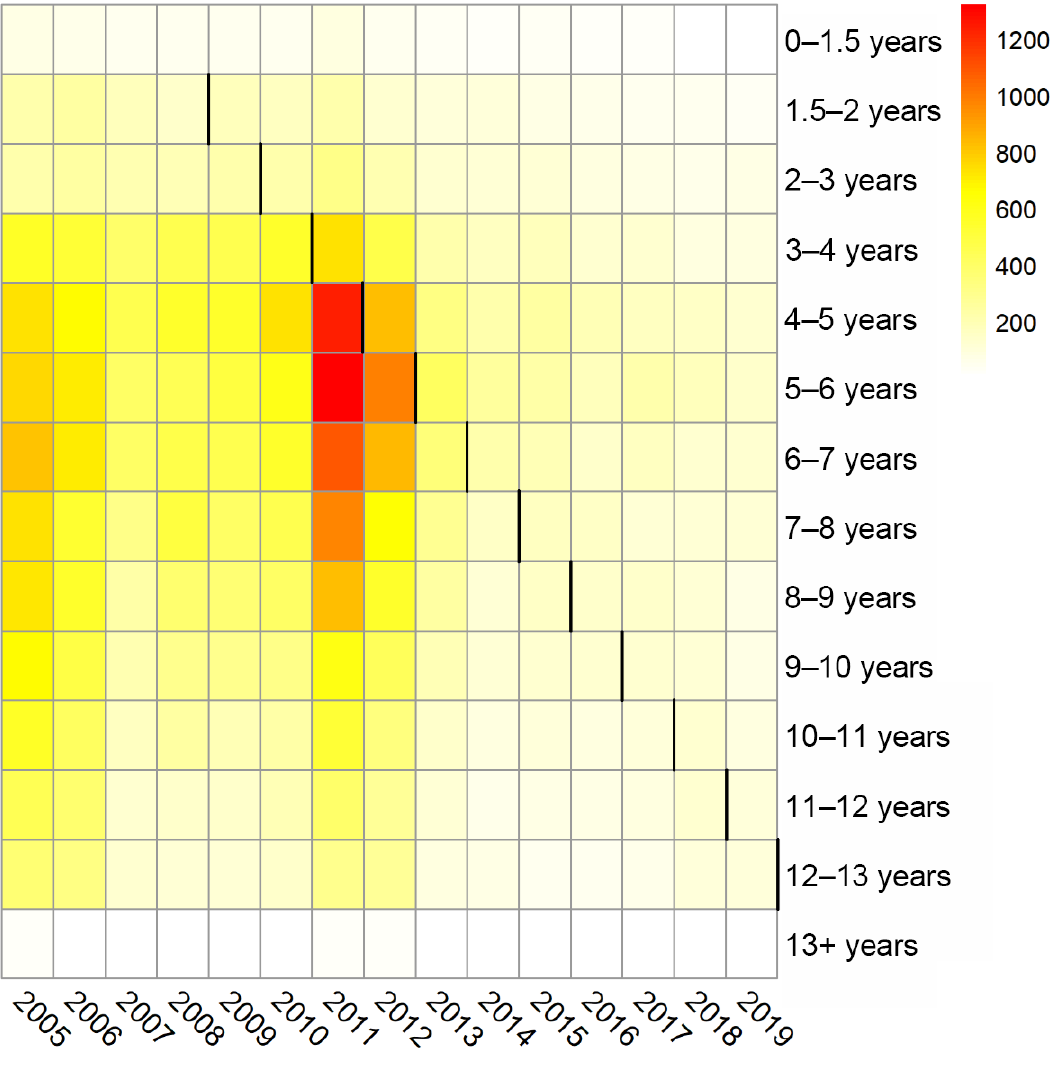
Figure 1. Heat map of the annual mumps incidence (per 100,000 population) for 14 age groups during 2005 – 2019. The black line indicates the year in which the intervention began for the age group.